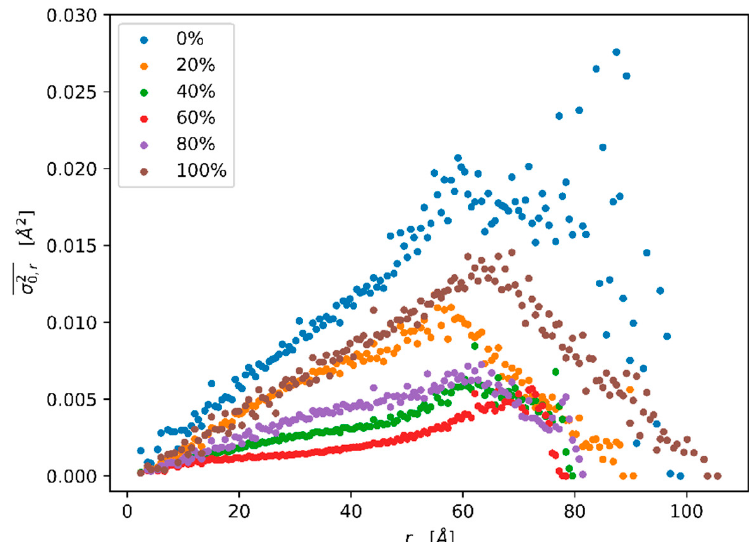
Figure A3. Static MSRD results for nanoparticle of roughly the same number of atoms of a cube of edge 6 nm (15,000 atoms), but with different degrees of truncation (0% is a cube, 100% an octahedron). The overall shape is always similar to the expression A9, except for the case of more “spherical” shapes (truncation 40% and 60%) that exhibit a trend closer to the sphere (Figure 3 in main text). Compared to Figure A3, the data have been presented with larger bins for a better visualization of the trends.